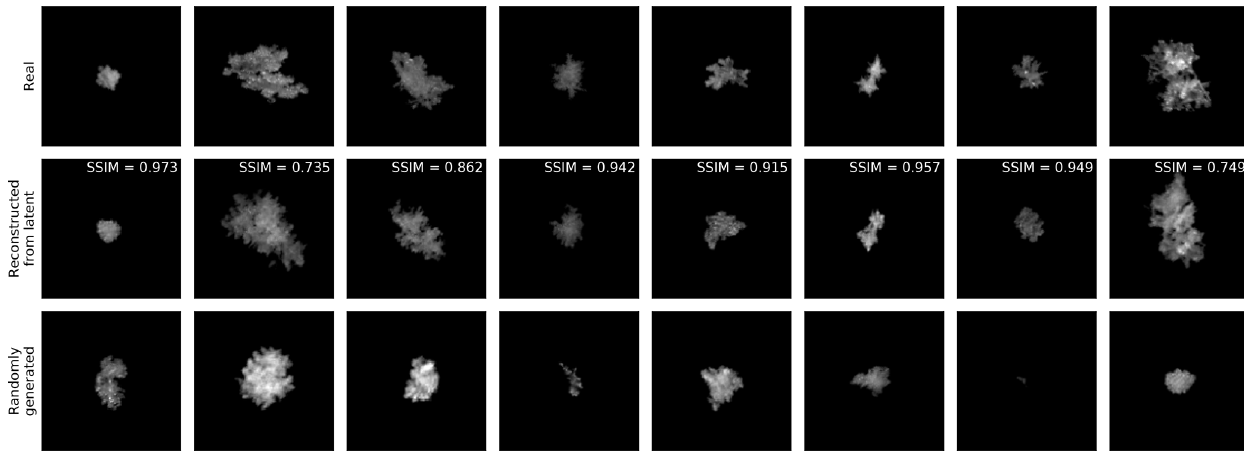
Figure 2. Samples of real and generated images. Top row: real images from the dataset. Middle row: images generated by extracting the latent variables from the corresponding top-row image and then generating an image with the GAN generator from that image; the SSIM between the real and generated images is also shown. Bottom row: samples of snowflake images generated from random latent